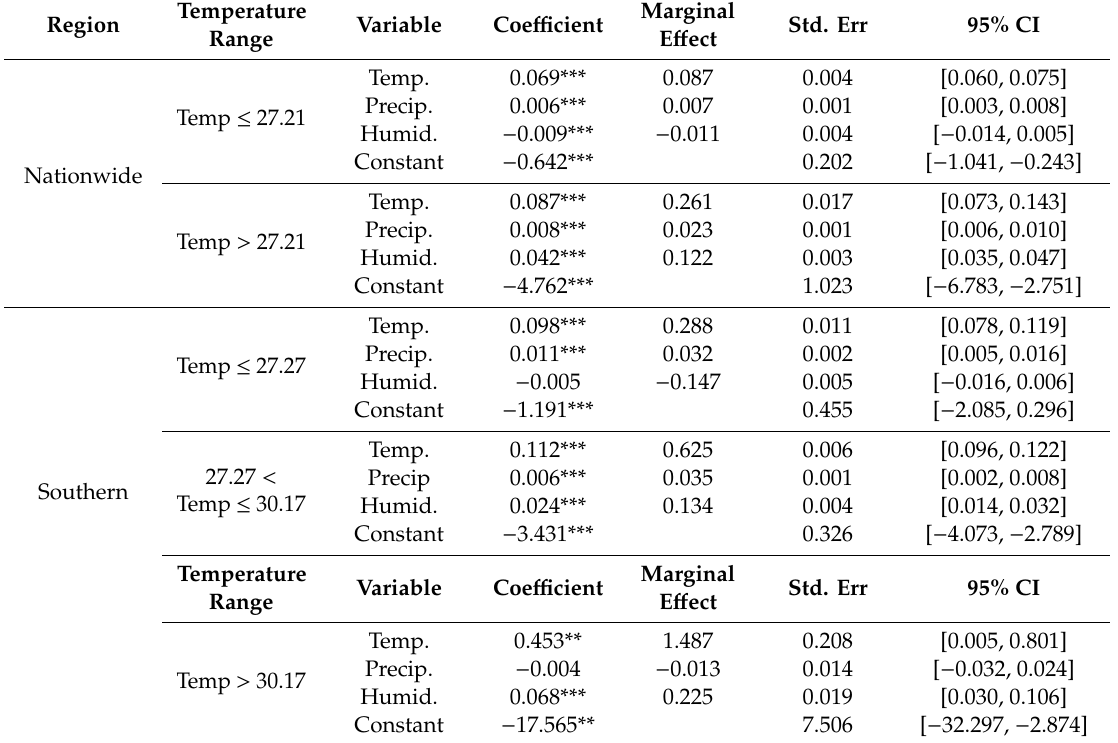
Table 5. Estimation results of the e ff ects of weather factors on Breteau